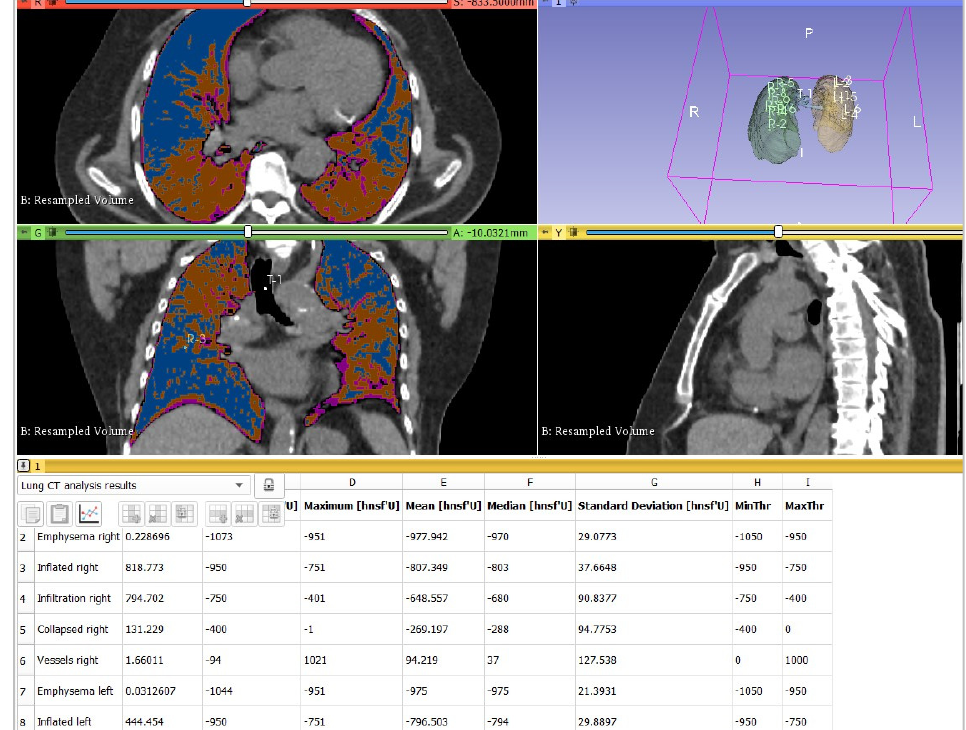
Figure 3. LungCTAnalyzer and the thresholds used. Here is an example of the analysis pursued. It was quantified that the “emphysematous”, “inflated”, “infiltrated”, and “collapsed” lung parenchyma were affected, and also their respective percentages were calculated.